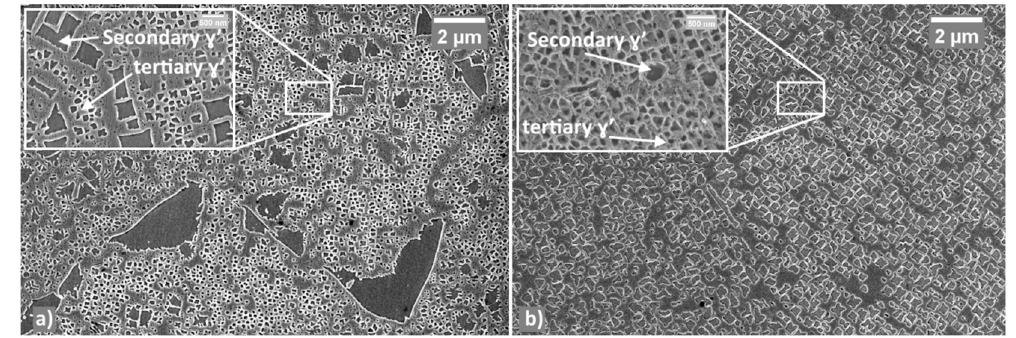
Figure 7. The microstructure of LT sample after second aging ( a ) and HT sample ( b ).